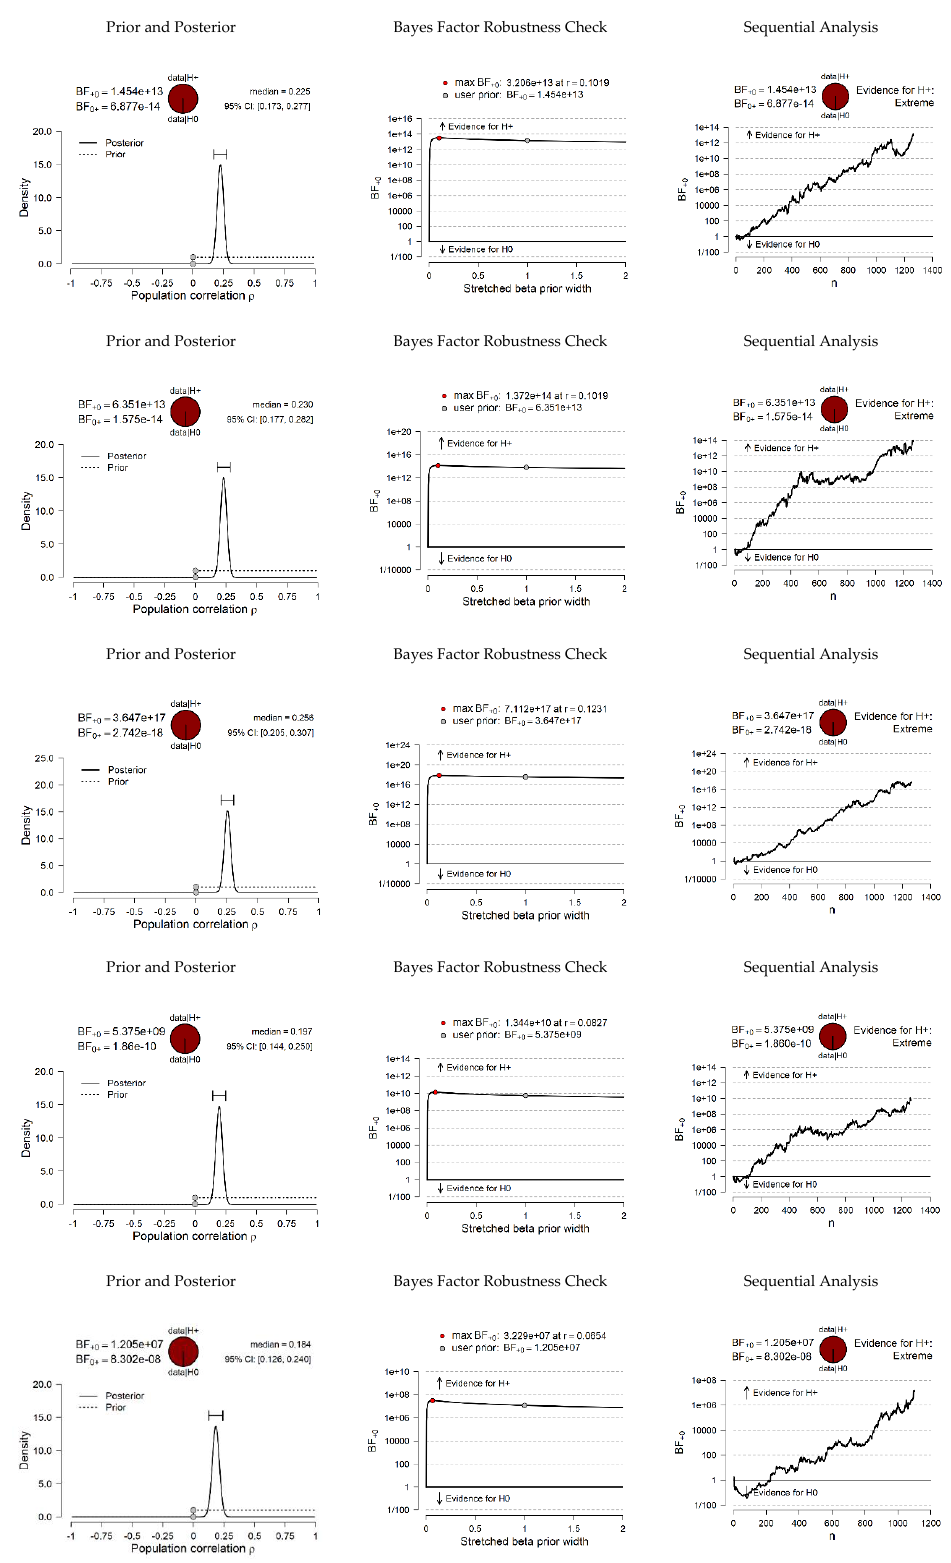
Figure 1. Bayesian correlation pairs. (Note: for all tests, H 1 specifies that the correlation is